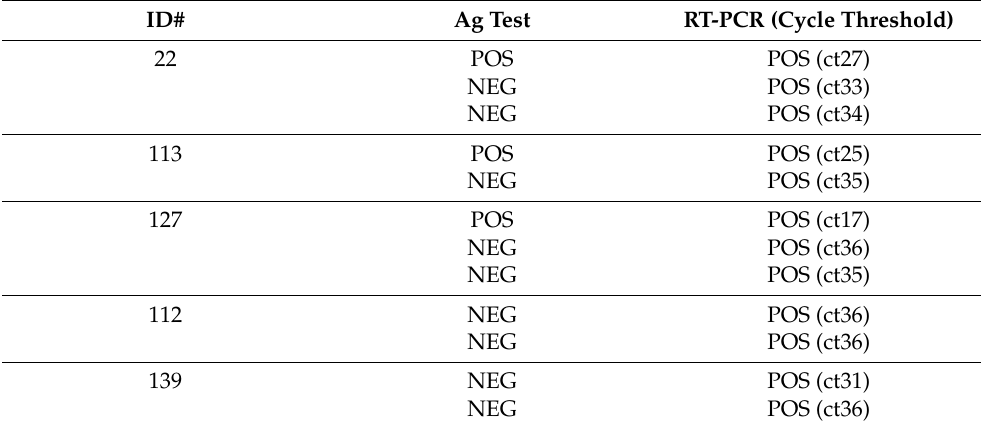
Table 2. Longitudinal study of selected asymptomatic